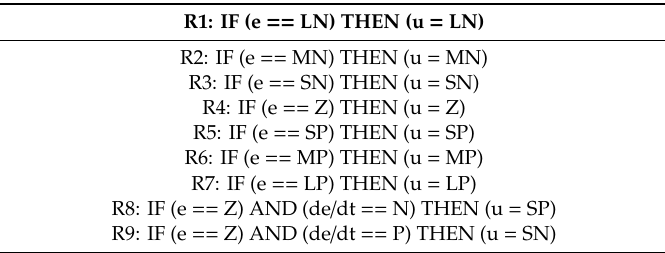
Table 4. The first version of the controller–rules.